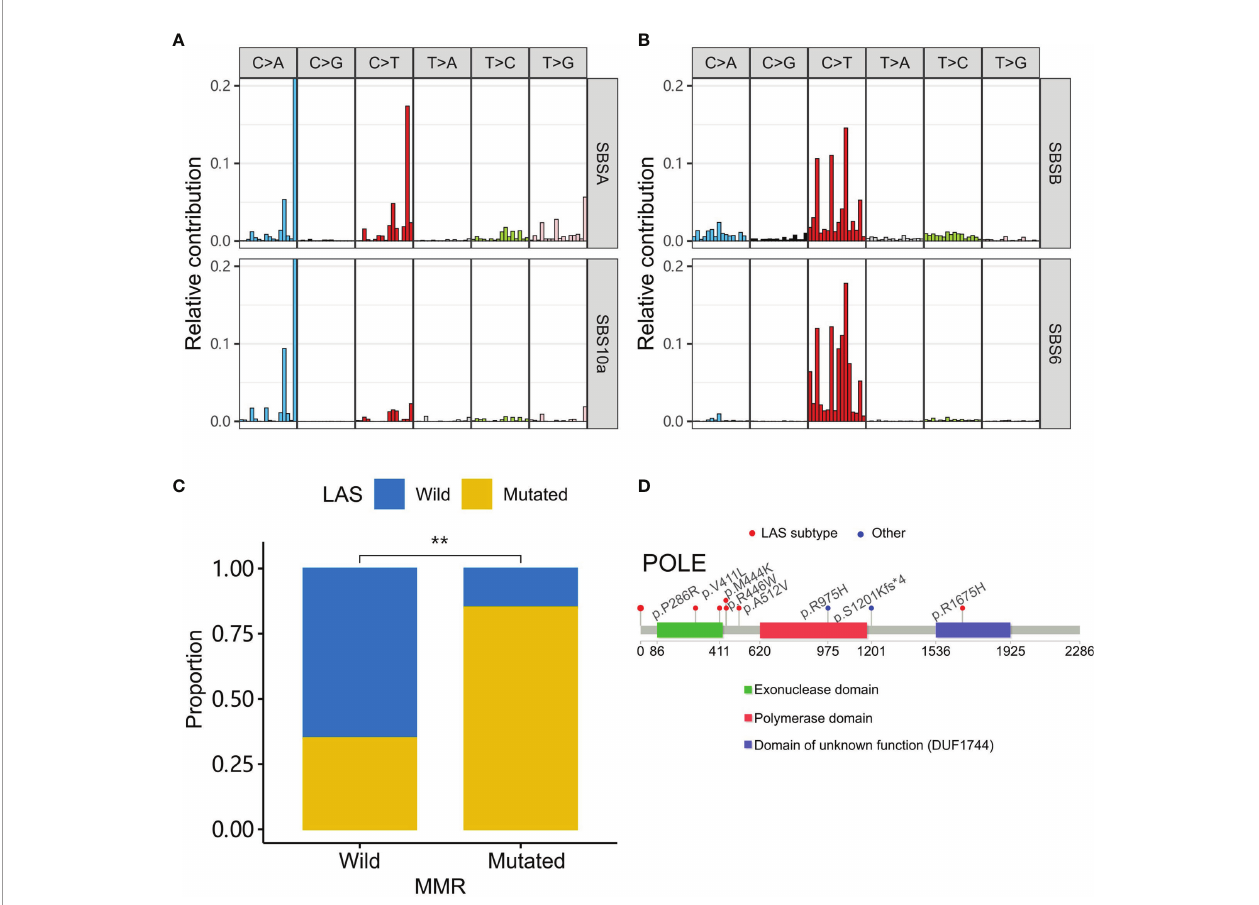
FIGURE 5 | LAS subtype-associated mutation signatures. (A, B) Two signatures (SBSA and SBSB) are extracted in the cohort. They are respectively similar to the signatures, SBS10a and SBS6 of the COSMIC database. (C) MMR gene ( MSH2 , MSH3 , MSH6 , MLH1 , MLH3 , PMS2 , PMS1 , EXO1 , POLD3 , PCNA , RPA1 , HMGB1 , RFC1 , and LIG1 ) mutations are higher in the LAS subtype CRC. (D) Mutations in the tumors of LAS subtype patients are around the exonuclease domain of polymerase epsilon. “ ** ” denote P -value <